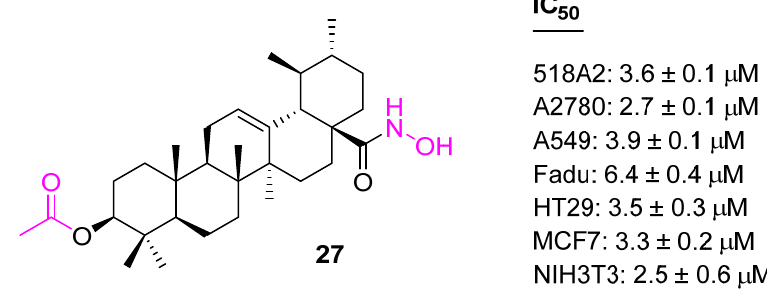
Figure 16. Structure of 26 . UA-derived hydroxamates were synthesized by adding a C3 acetyl group; they were screened for their cytotoxicity utilizing SRB assays against several human tumor cell lines. Among the various hydroxamates, compound 27 (Figure 17) was found to be the most potent against seven cancer cell lines. However, unfortunately, these hydroxamates were